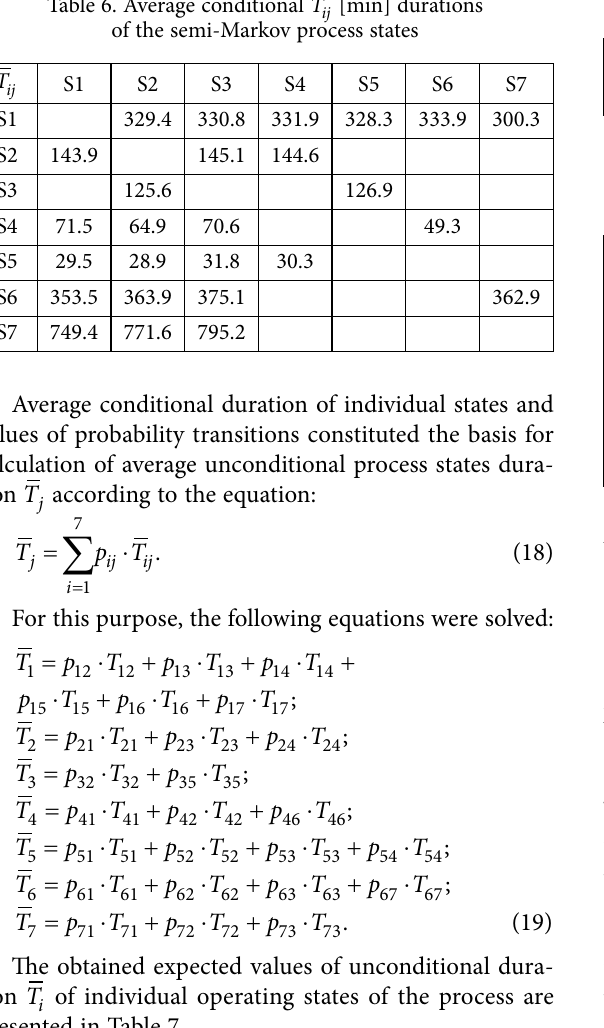
Table 7. Unconditional times i T [min]